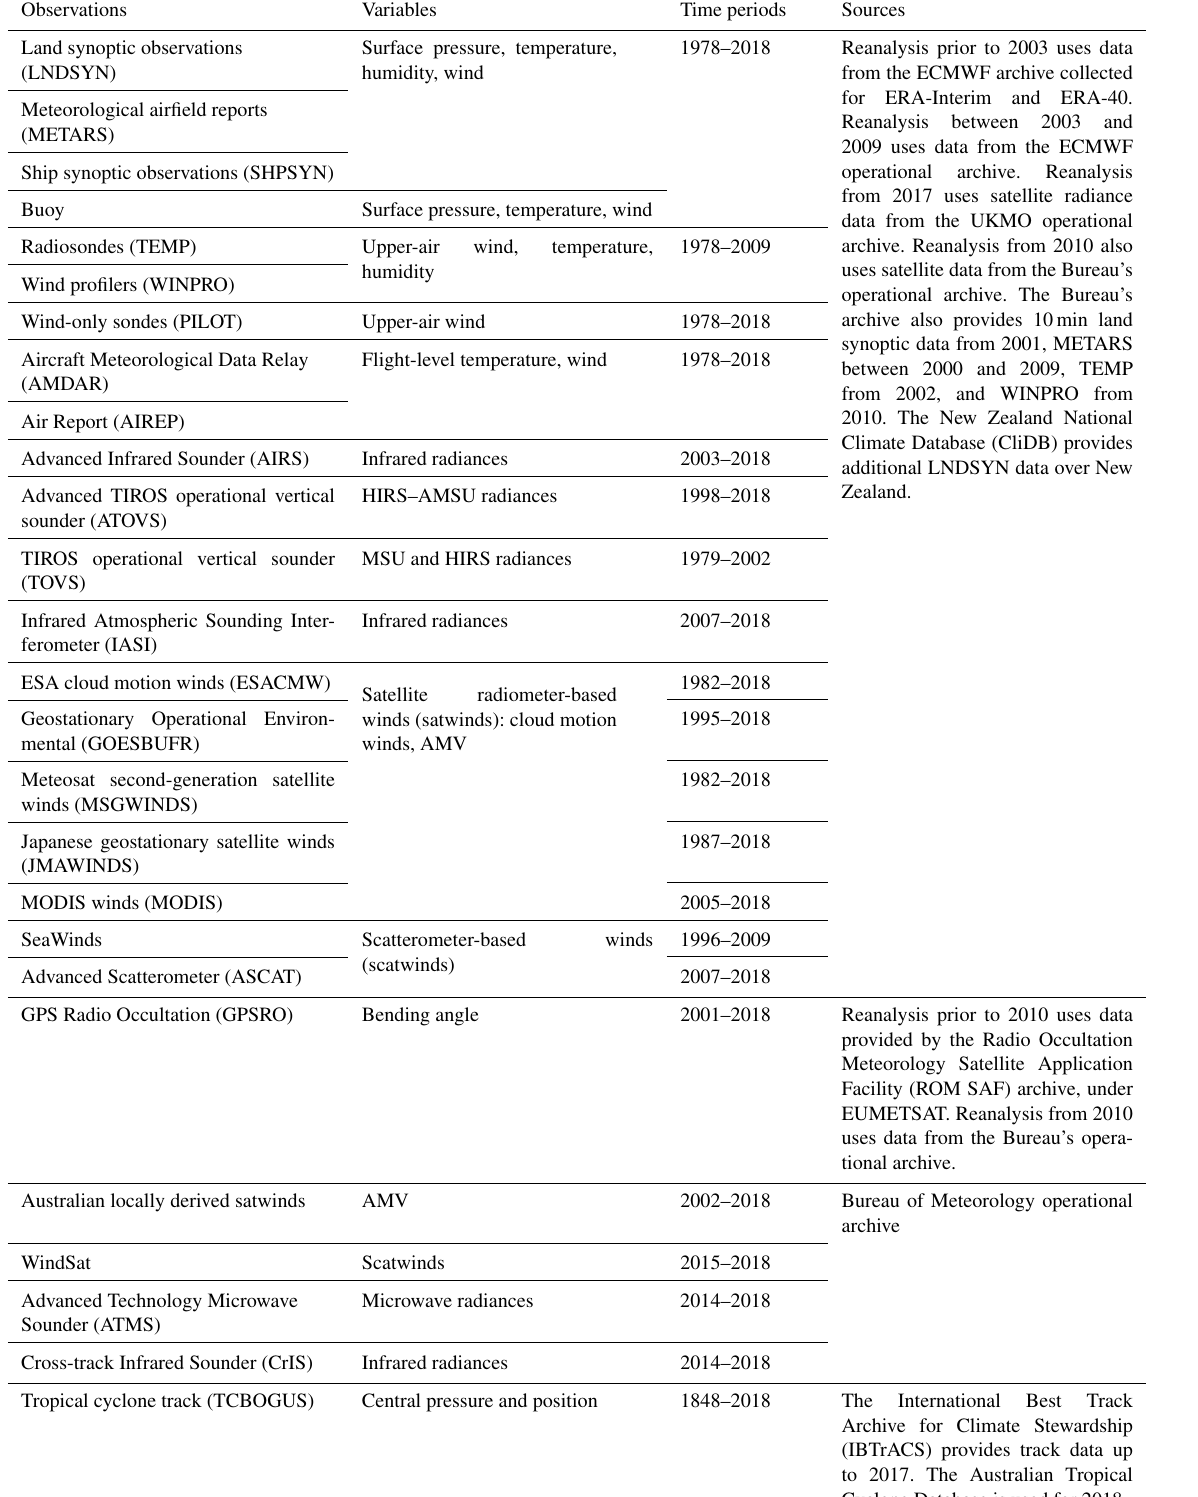
Table 1. Observations assimilated in BARRA. Only the period concurrent with the reanalysis period is used. The various datasets were retrieved during the production, and thus the exact periods of each set used may